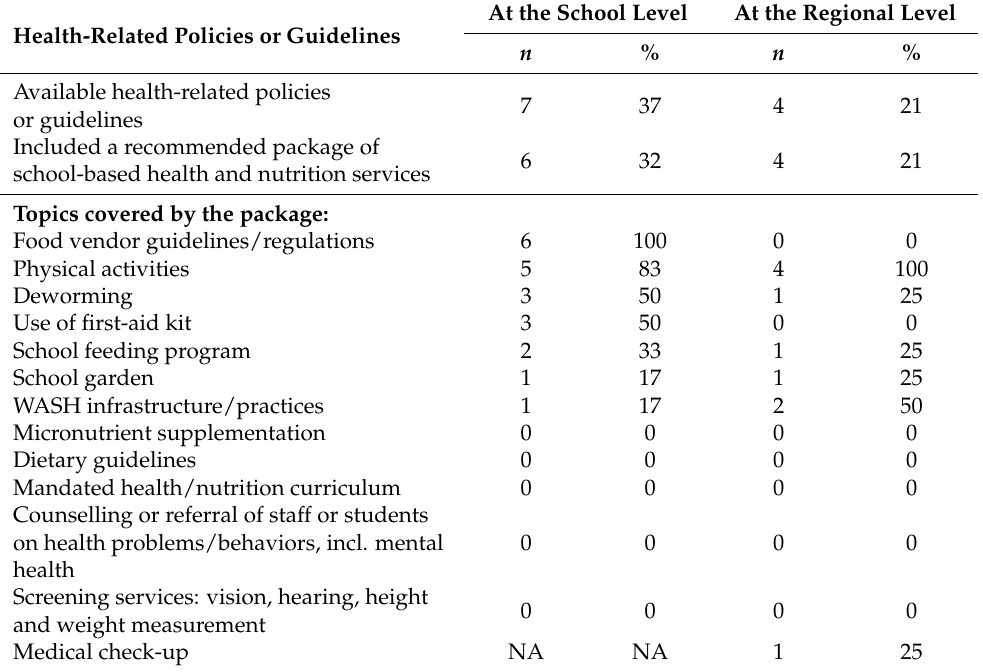
Table 1. Availability of health-related policies or guidelines as reported by the school administrators from 19 junior secondary schools in Ouagadougou.